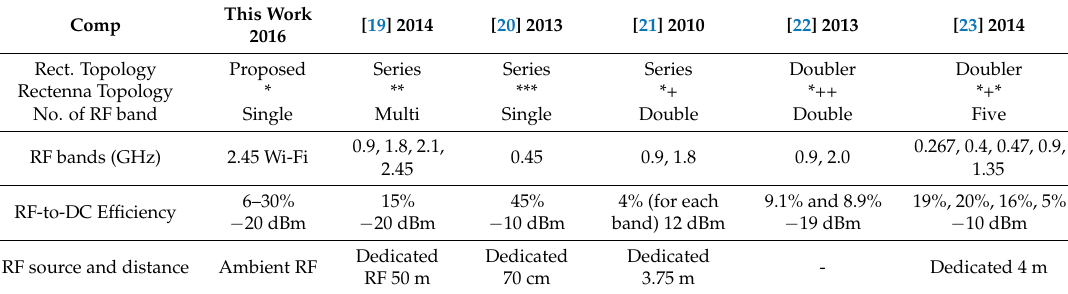
Table 6. System performance